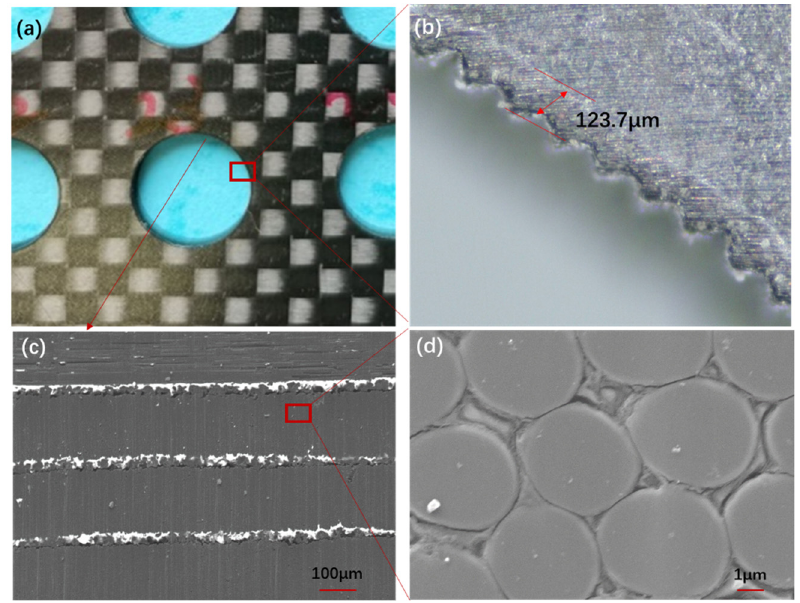
Figure 5. ( a ) Cutting hole in CFRP plate; ( b ) HAZ around the cutting hole; ( c ) cutting profile; ( d ) microstructure of the cutting profile.